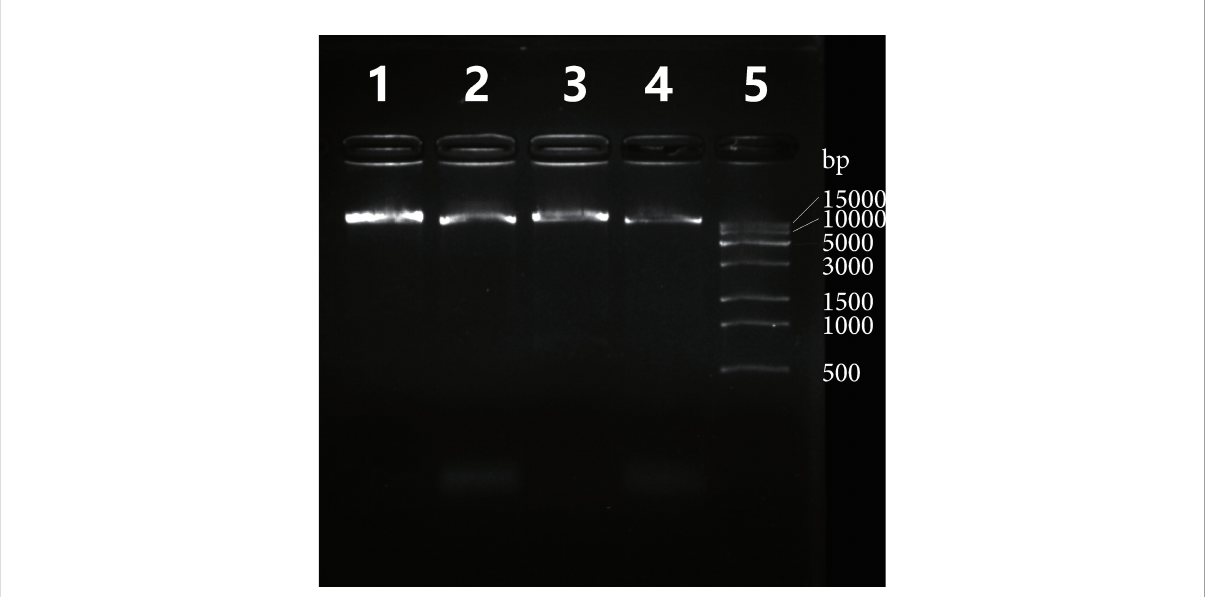
FIGURE 3 PCR evaluation of recombination mediated by a ~16 kp repeat pair (R1) in the Aeginetia indica mitogenome. Shown are results of DNA gel electrophoresis of ampli fi ed PCR products. Lane 1: PCR ampli fi cation of R1_a and fl anking regions (primer: a_F and a_R); Lane 2: PCR ampli fi cation of R1_b and fl anking regions (primer: b_F and b_R); Lane 3: PCR ampli fi cation for the recombined conformation 1 (primer: a_F and b_F); Lane 4: PCR ampli fi cation for the recombined conformation 2 (primer: a_R and b_R); Lane 5: DNA ladder. Expected sizes for these PCR products are 17734, 17589, 17809 and 17514 bp for Lane 1, 2, 3 and 4, respectively.